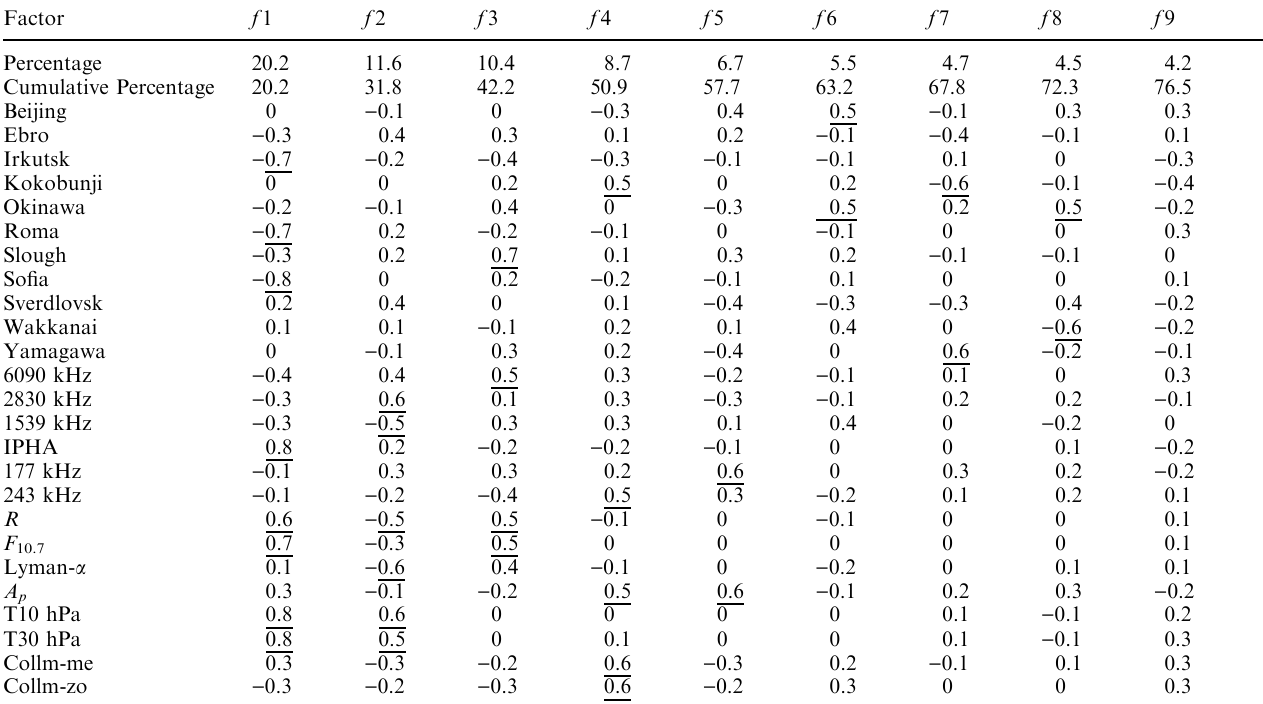
Table 7. PCA loadings (no axis rotation) for October–November 1994, all parameters studied. The first nine factors, which cover 76.5% of the total variance, are shown. Important loadings are underlined Factor